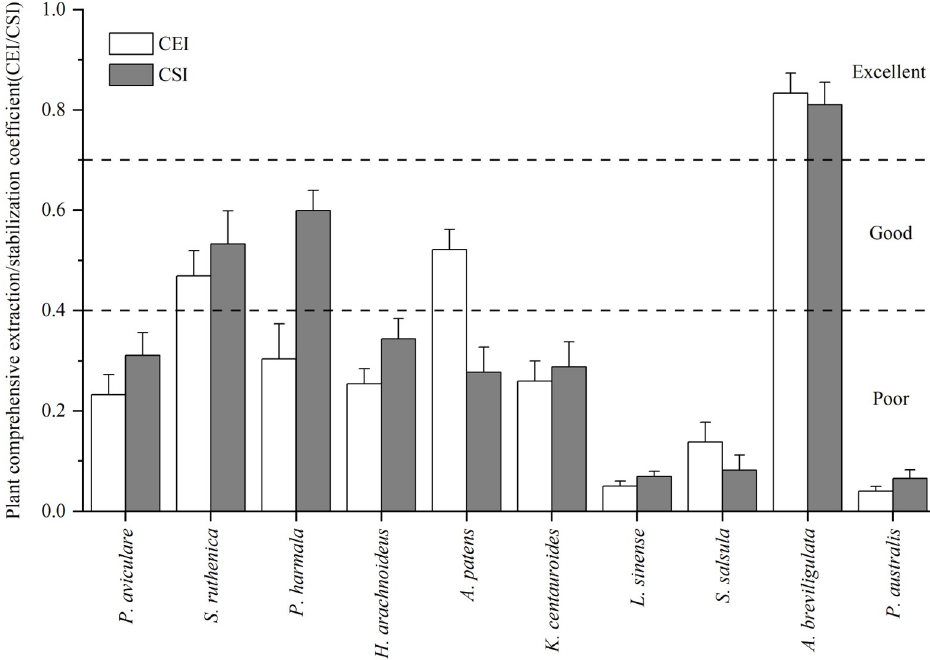
Fig 4. Plant comprehensive enrichment/stability coefficients for the 10 native plants.